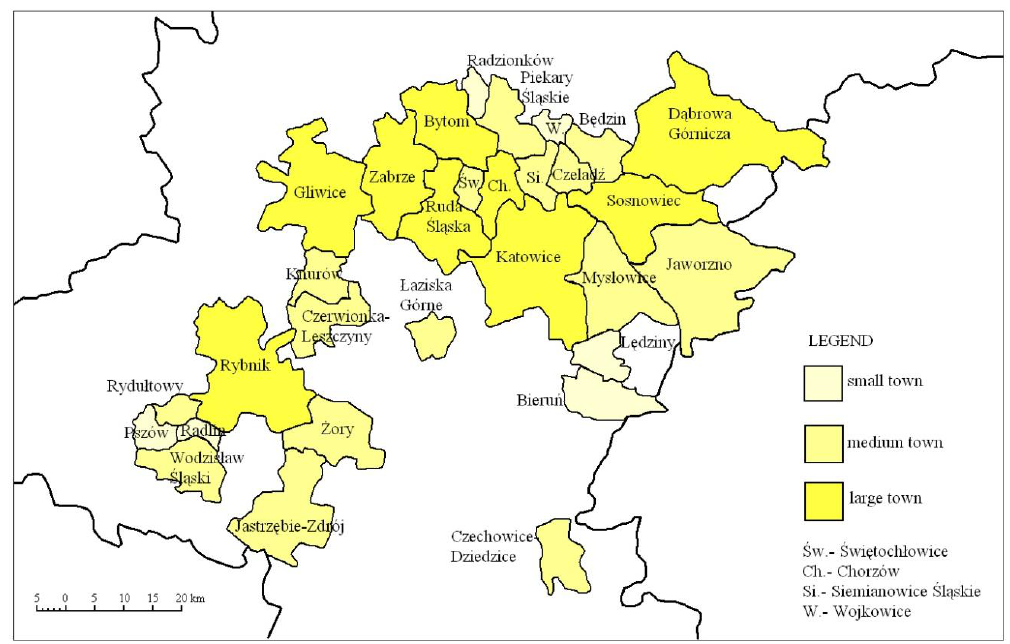
Fig. 1 Mining and post-mining towns in the Silesian voivodeship (author’s